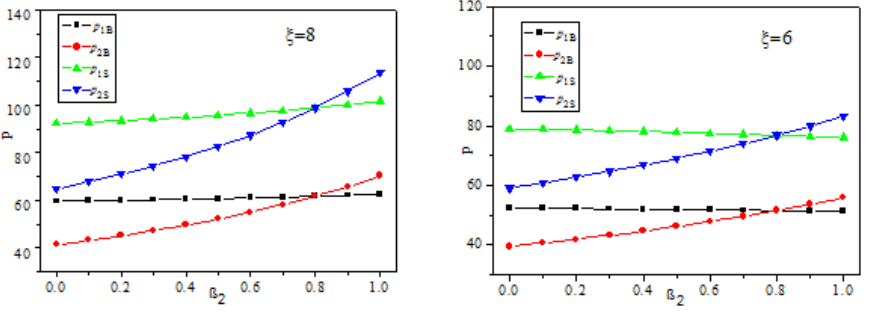
Figure 1. The change of the retail price with the return price in two